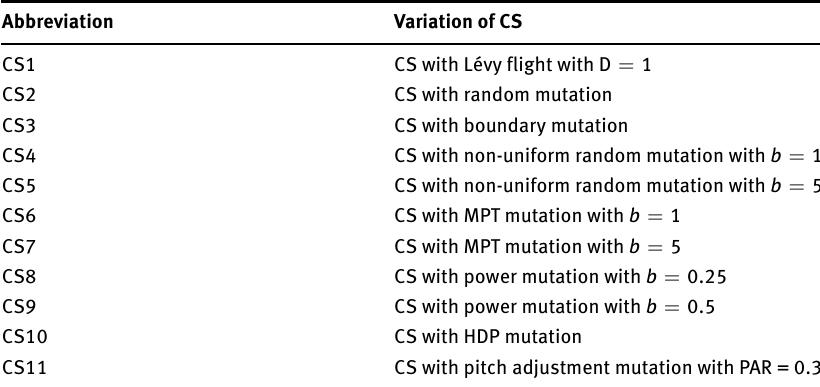
Table 2: Different Variations of